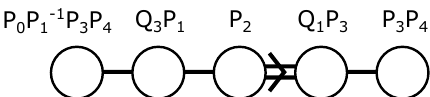
Figure 34. The Kähler parameters of the fibers which form the affine F 4 Dynkin diagram.